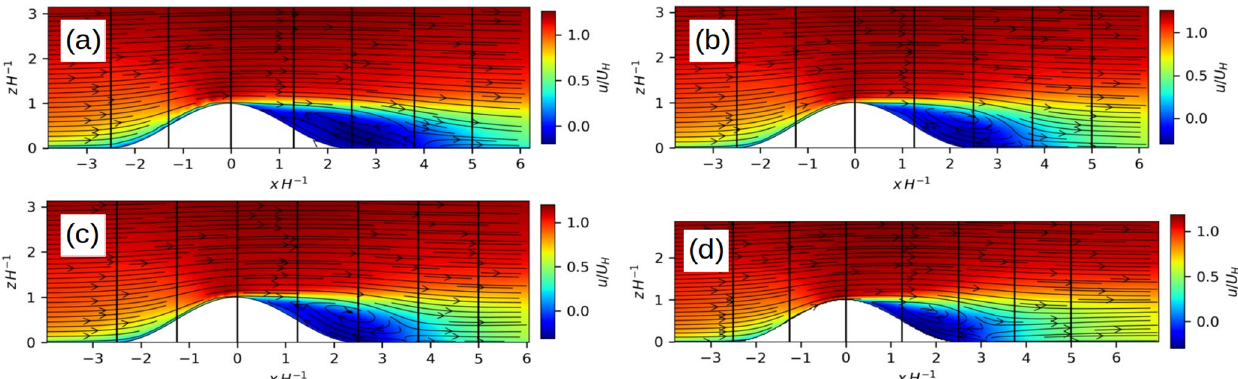
Figure 13. The 2h time-averaged vertical cross section of the u component field (colored contours) and the u – w mean flow field (vector arrows) displayed along the centerline of the three-dimensional hill for (a) the 4m reference simulation, (b) the 2m reference simulation, (c) the 2m nested child simulation, and (d) the 1m nested child simulation. Vector arrows and the u component are normalized, with the reference wind speed taken at z = H upwind of the hill. The ordinate and the abscissa are scaled with the hill height H . Note that the abscissa is centered at the hill top. The vertical black lines indicate the positions of the profiles displayed in Figs. 14 and 15. Note that the ordinate in (d) is constrained by the vertical dimension of the 1m child domain. Moreover, note that the x dimension in (c) and (d) do not show the entire child domain extents but instead cut out minor parts at the left and